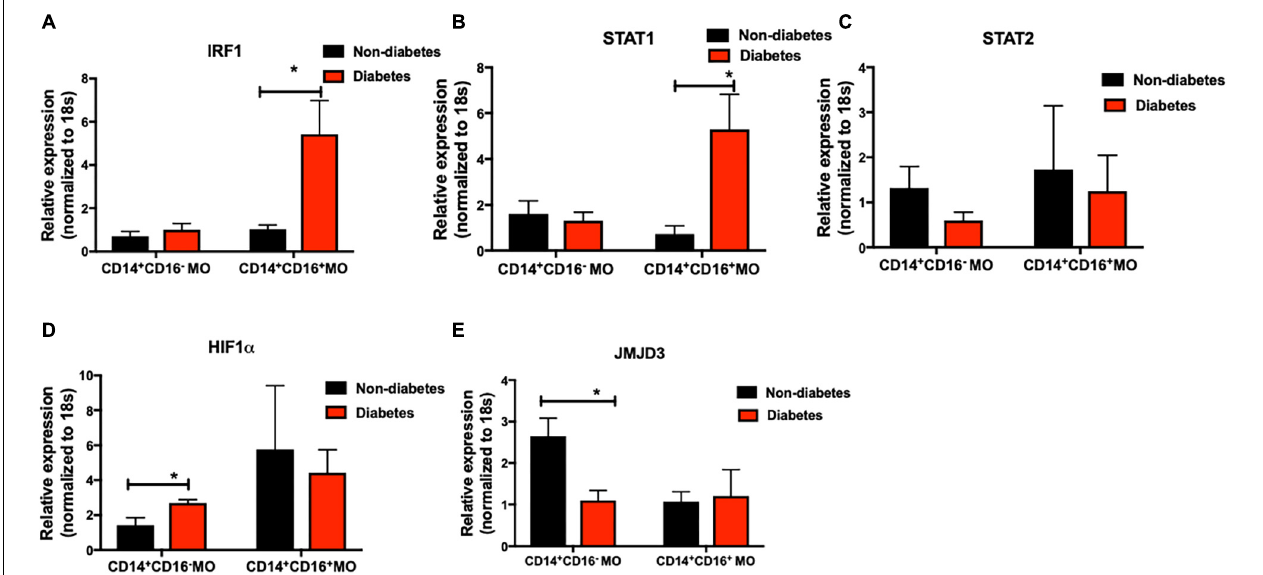
FIGURE 6 | Primary human monocytes were isolated from the circulation of individuals with and without T2DM (at least 5 donors in each group). mRNA was isolated and qPCR was performed to analyze gene expression. (A–E) IRF1, STAT1, STAT2, HIF1 α , JMJD3 levels were quantified by qPCR. 18 s was used as the endogenous normalizer. Data presented as mean ± SEM and p less than 0.05 was defined as significant (the symbol “*” indicates p <